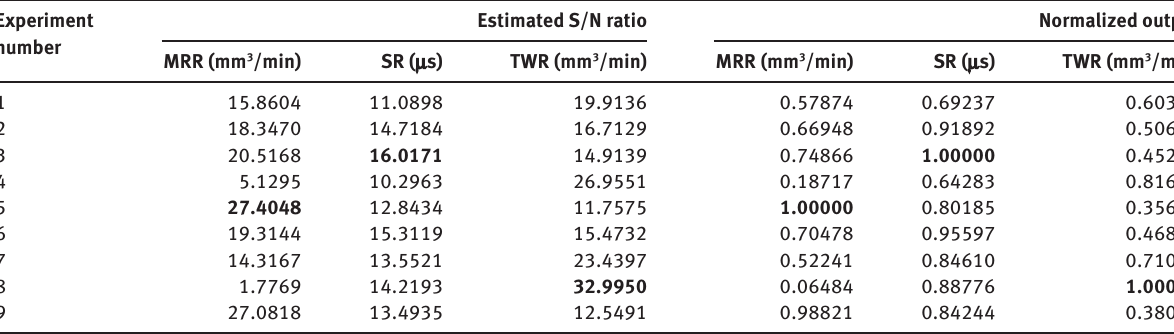
Table 14: Analysis of normalized output parameters ratio in the machining of 2024 alloy. Experiment number